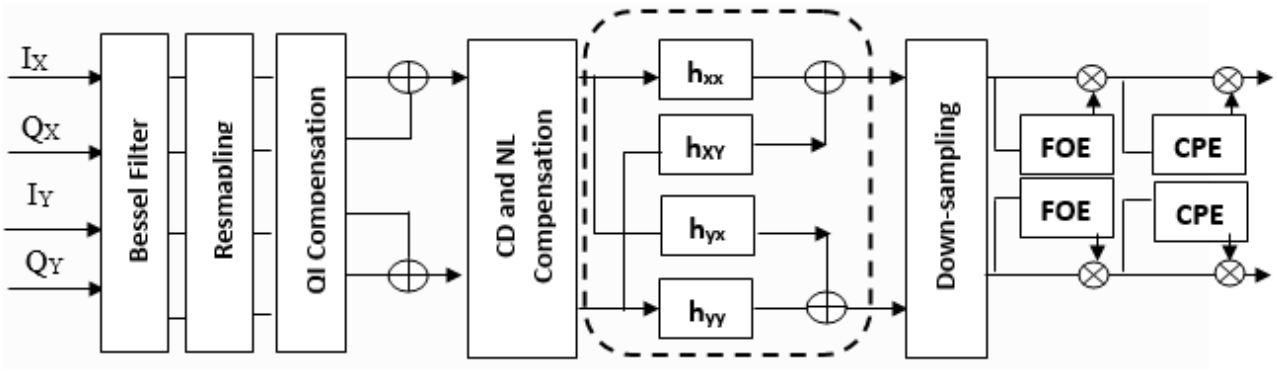
Figure 6. DSP module with 8 functions, pre-processing, and different algorithms.